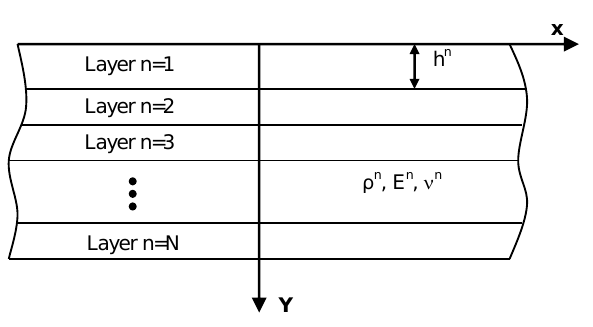
Fig. 1. Schematic illustrating the geometry of the N -layered composite